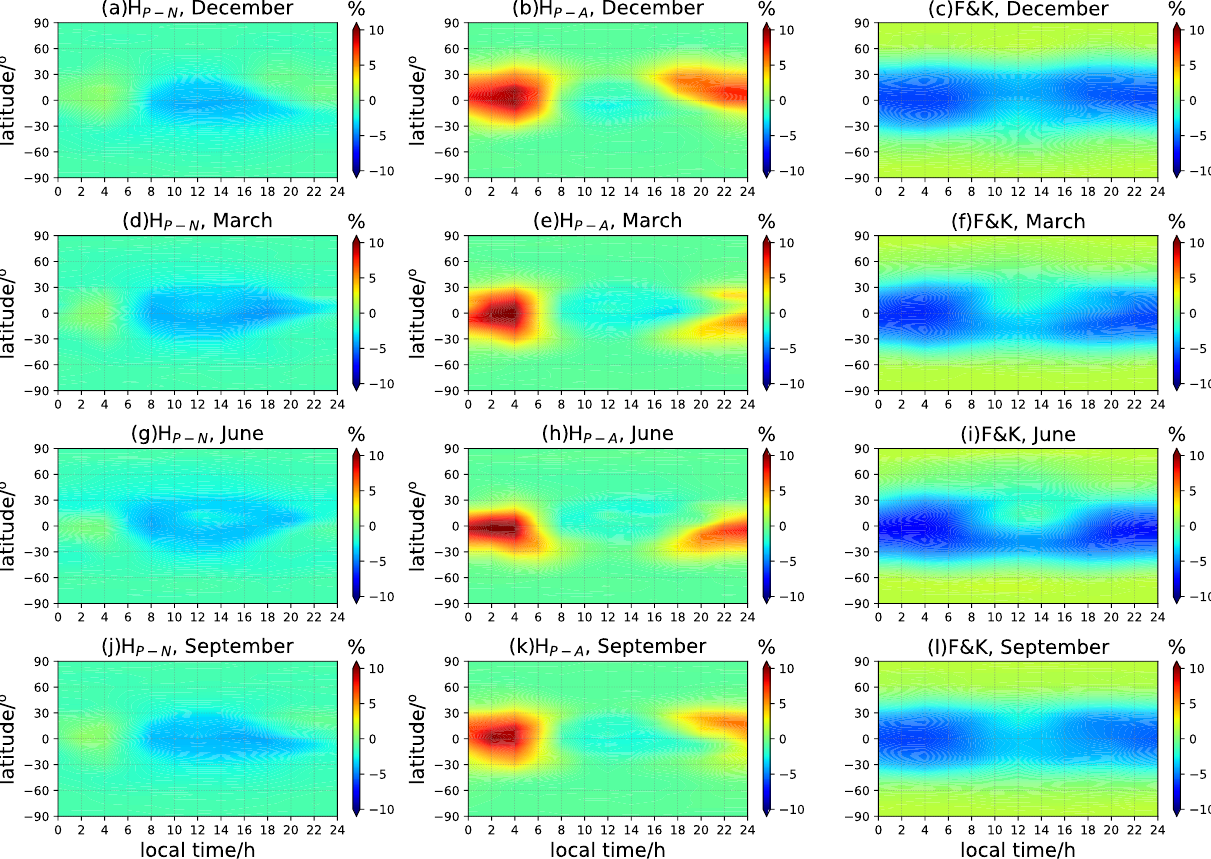
Figure 6. The local time and latitude-dependent variations of the retrieved VTEC mean deviation for the mapping experiments in different seasons in LSA years. The zenith angle is fixed at 40° . The ‘ 𝐻 𝑃_𝑁 ’, ‘ 𝐻 𝑃_𝐴 ’, and ‘F&K’ represent the numerical and analytical mapping functions and the F&K model, respectively; panels ( a ), ( d ), ( g ) and ( j ) are 𝐻 𝑃_𝑁 -based mapping errors; ( b ), ( e ), ( h ) and ( k ) are 𝐻 𝑃_𝐴 -based mapping errors; ( c ), ( f ), ( i ) and ( l ) are F&K mapping errors.